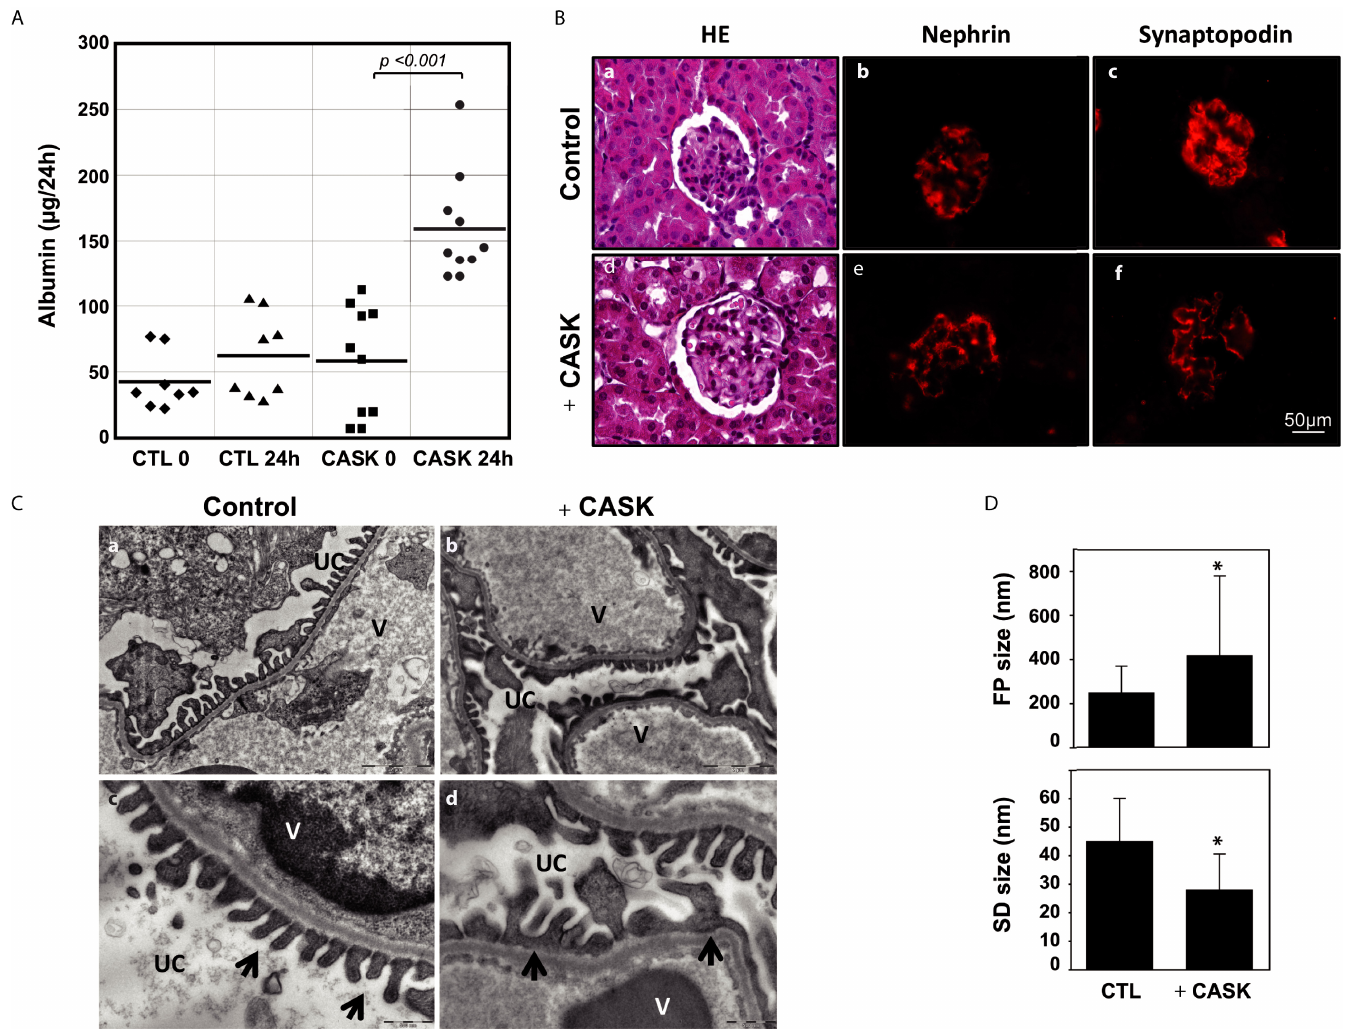
Fig 6. Functional and structural effects of CASK in mice. A) A single injection of CASK induced significant proteinuria compared with levels at time 0 (CASK 0, p < 0.001) or those of the controls (mouse albumin, p < 0.0001) after 24 h. B) Microscopy of renal biopsy stained with hematoxylin-eosin of control mice (a) or mice treated with rCASK (d) respectively. Immunofluorescence microscopy analyses of podocytes in control mice or mice treated with rCASK with antibodies against nephrin (b,e) or synaptopodin (c,f). We did not observe any significant alterations in glomerular structures based on hematoxylin-eosin staining or immunofluorescence of cytoskeleton proteins (actin/synaptopodin). C) A single IV injection of rCASK induced ultrastructural modifications in the glomeruli. Electron microscopy revealed effacement of the foot processes, giving the appearance of fusion ( arrows ) (b,d) but not in control (a,c). UC: urinary chamber V: vessel. D) The sizes of the foot processes (FP) and the slit diaphragms (SD) were measured (right images): CASK significantly increased the size of foot processes, while the slit diaphragms were reduced ( � p <